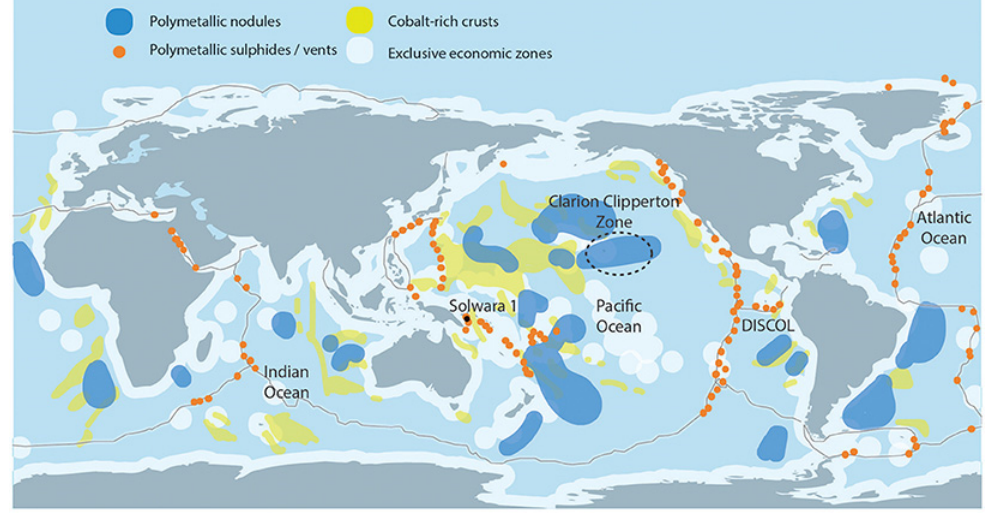
Figure 43. Map showing the locations of the three main marine mineral deposits: polymetallic nodules (blue); polymetallic or seafloor massive sulphides (orange); and cobalt-rich ferromanganese crusts (yellow). Reproduced from [139] which in turn drew on [137].